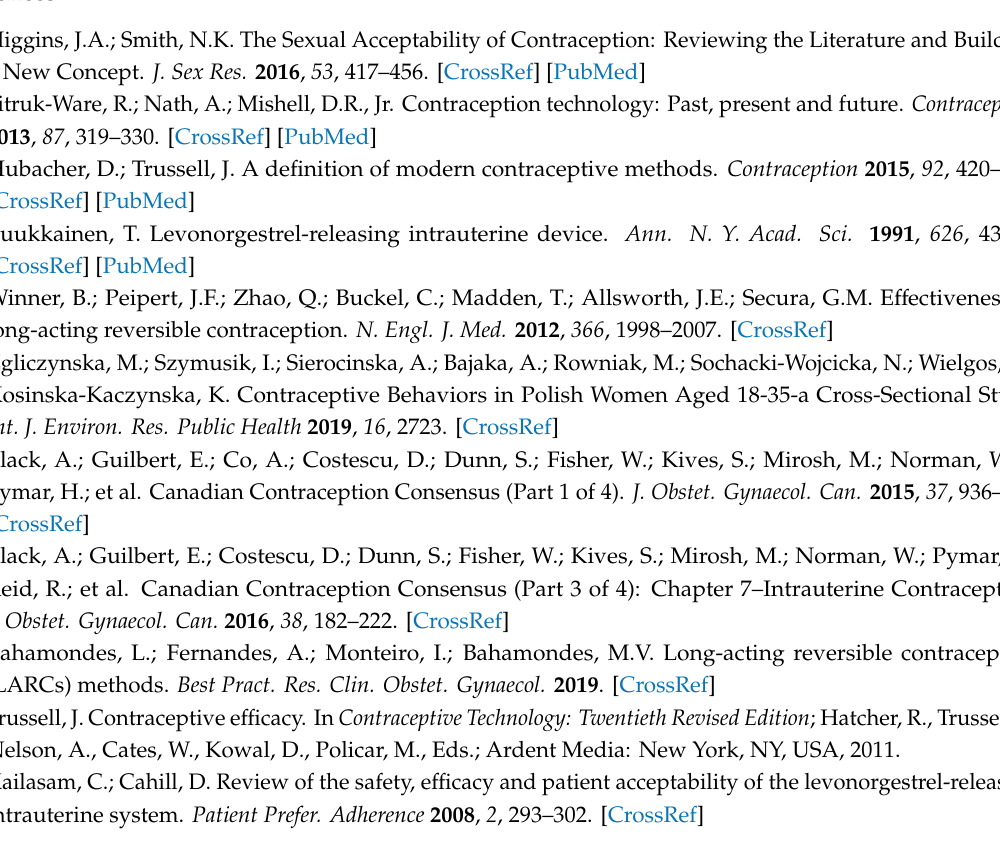
Figure S1. PRISMA 2009 Flow Diagram, Table S1. The search methods for used databases, Table S2. Risk of bias